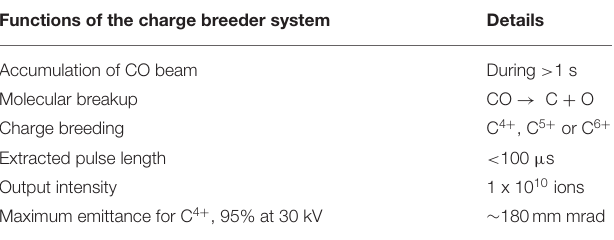
TABLE 6 | Summary of the required functions of the charge breeding system for a hadron therapy facility based on a synchrotron, as used in ( 95). Functions of the charge breeder system